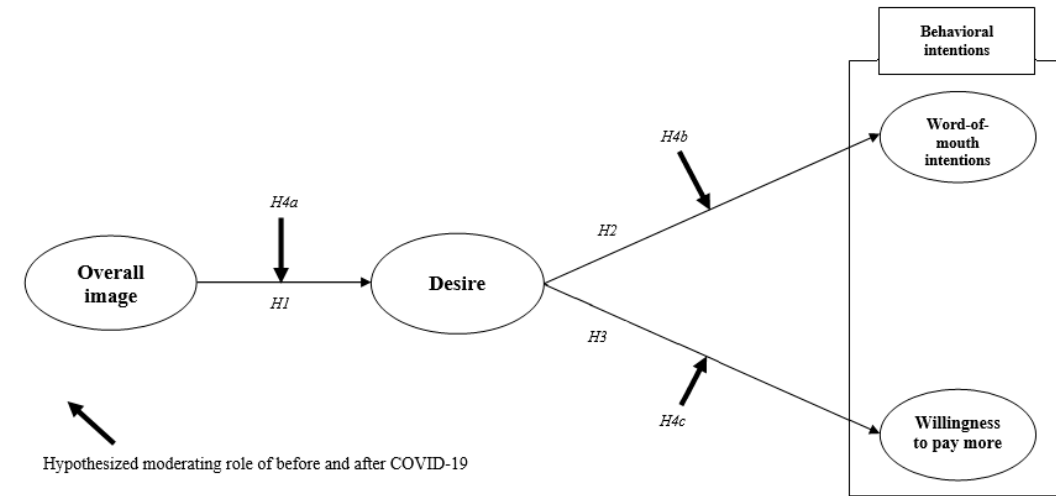
Figure 1. The proposed conceptual model.